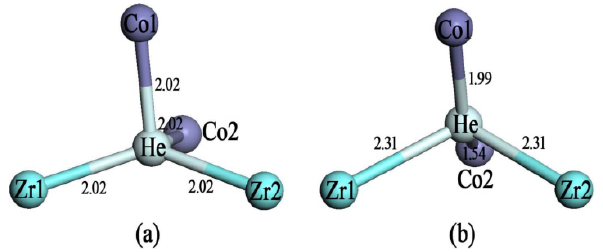
Figure 1. The two 8 e positions ( a ) and ( b ) occupied by He around the 8 e site. The distances (Å) among the atoms are also labeled. Zr1 and Zr2 are the labeled two Zr atoms surrounding an 8 e site, and Co1 and Co2 are the labeled two Co atoms surrounding an 8 e site. He suggests the positions occupied by the He atom. The bond lengths are also labeled.